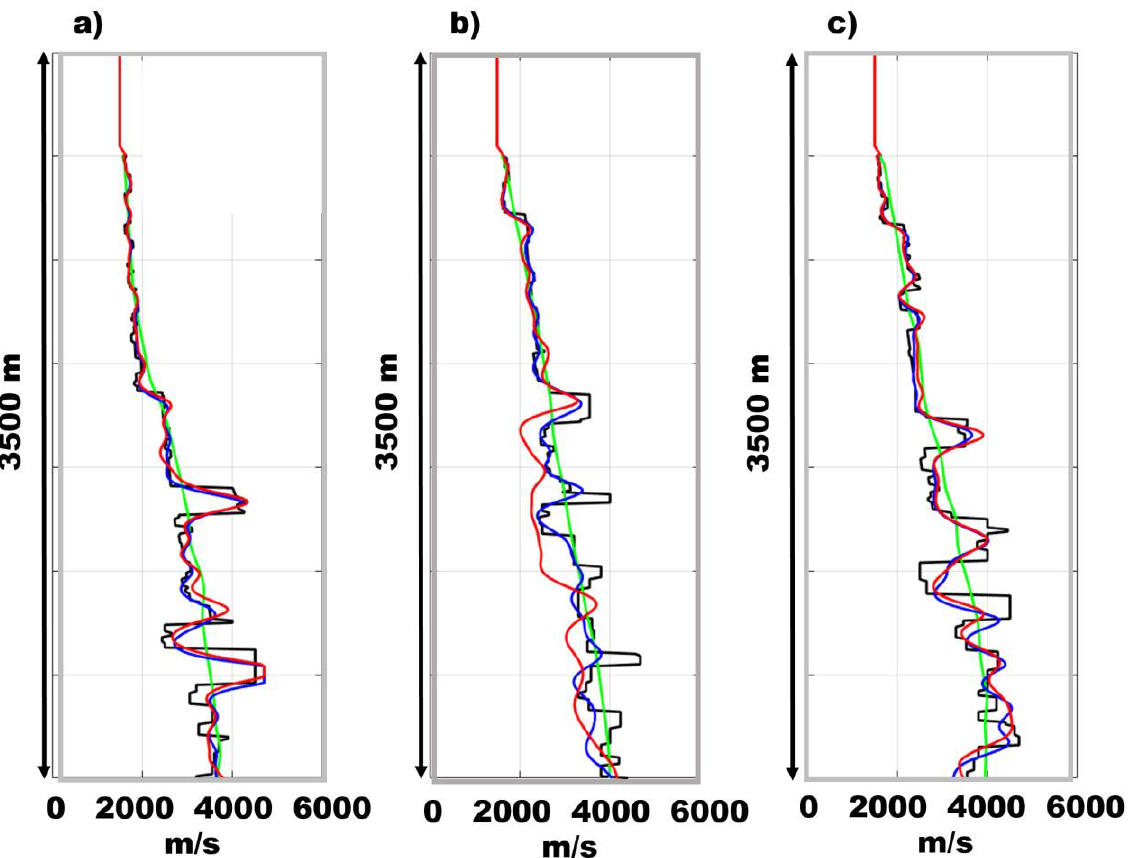
Figure 9. Vertical velocity profiles for various lateral coordinates and various inversion scenarios for frequencies {5,7,10} Hz, black represents the true speed model, green — starting model, blue — classic FWI, and red — asymptotic FWI: ( a ) x = 2000 m; ( b ) x = 5000 m; ( c ) x = 8000 m.